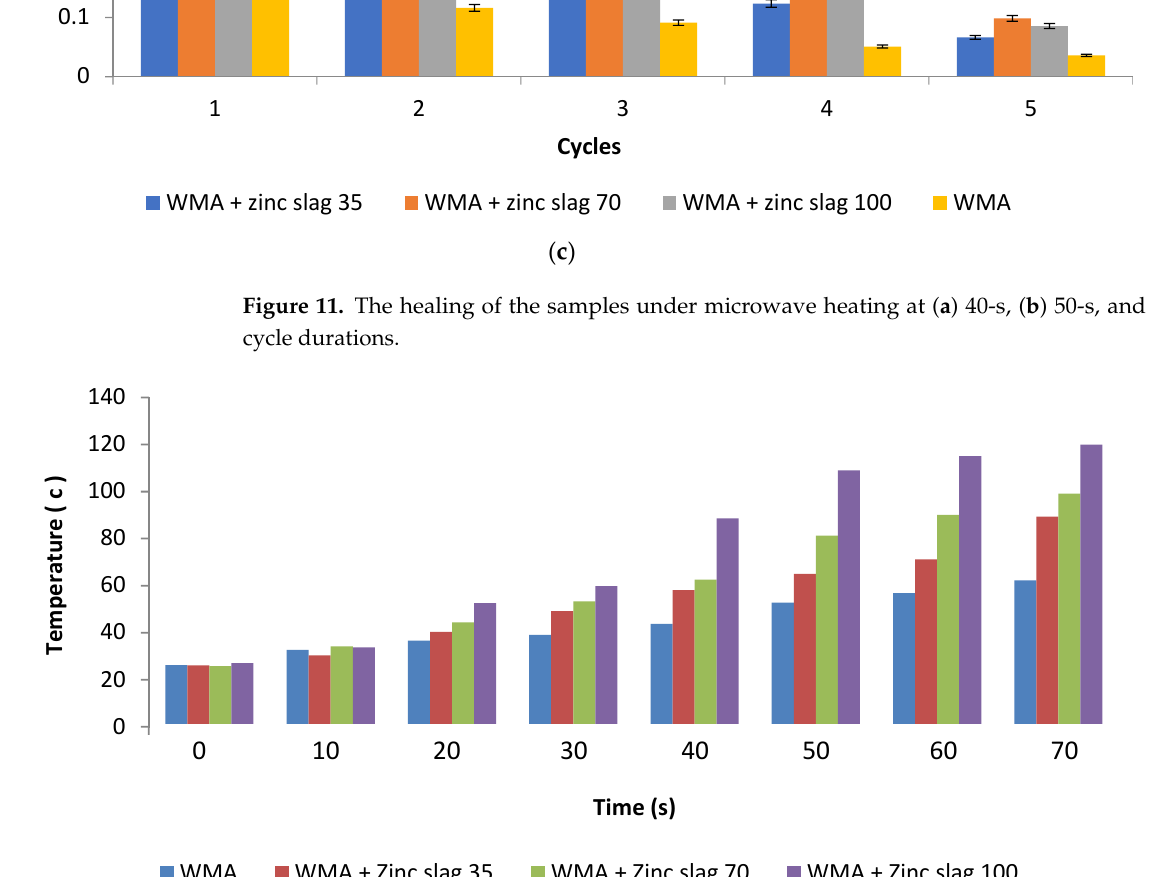
Figure 12. Changes in sample temperature (mean temperature) against microwave heating time.